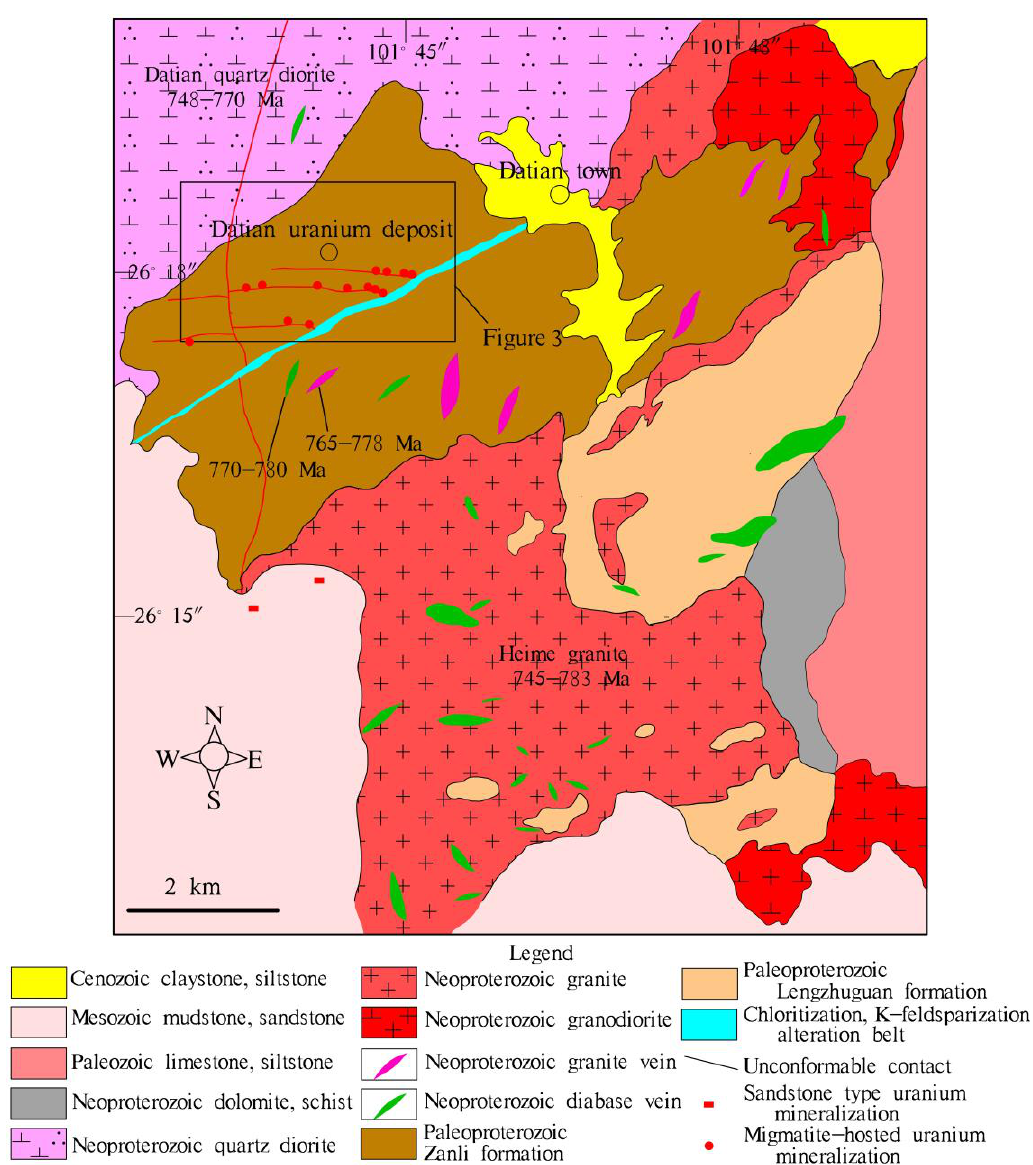
Figure 2. Schematic geologic map of the Datian area. The age of the Datian quartz diorite, Heime granite, granite vein, and diabase veins are from the literature [14,19,21].